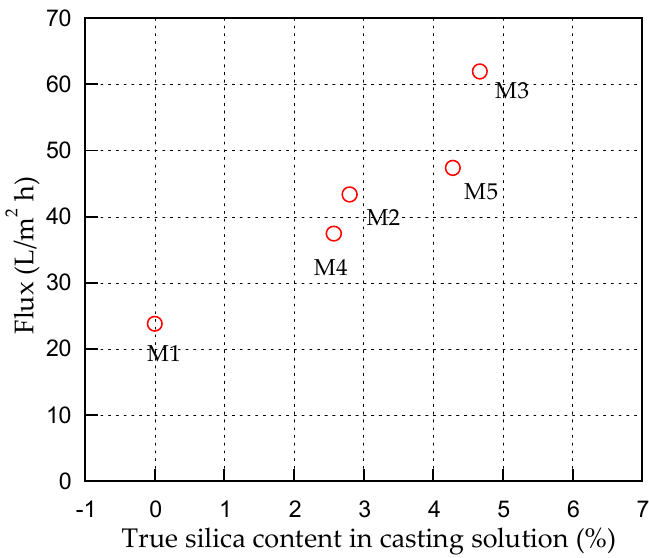
Figure 5. E ff ect of concentration and type of biosilica on pure water flux obtained at trans-membrane pressure of 3.5 bar.